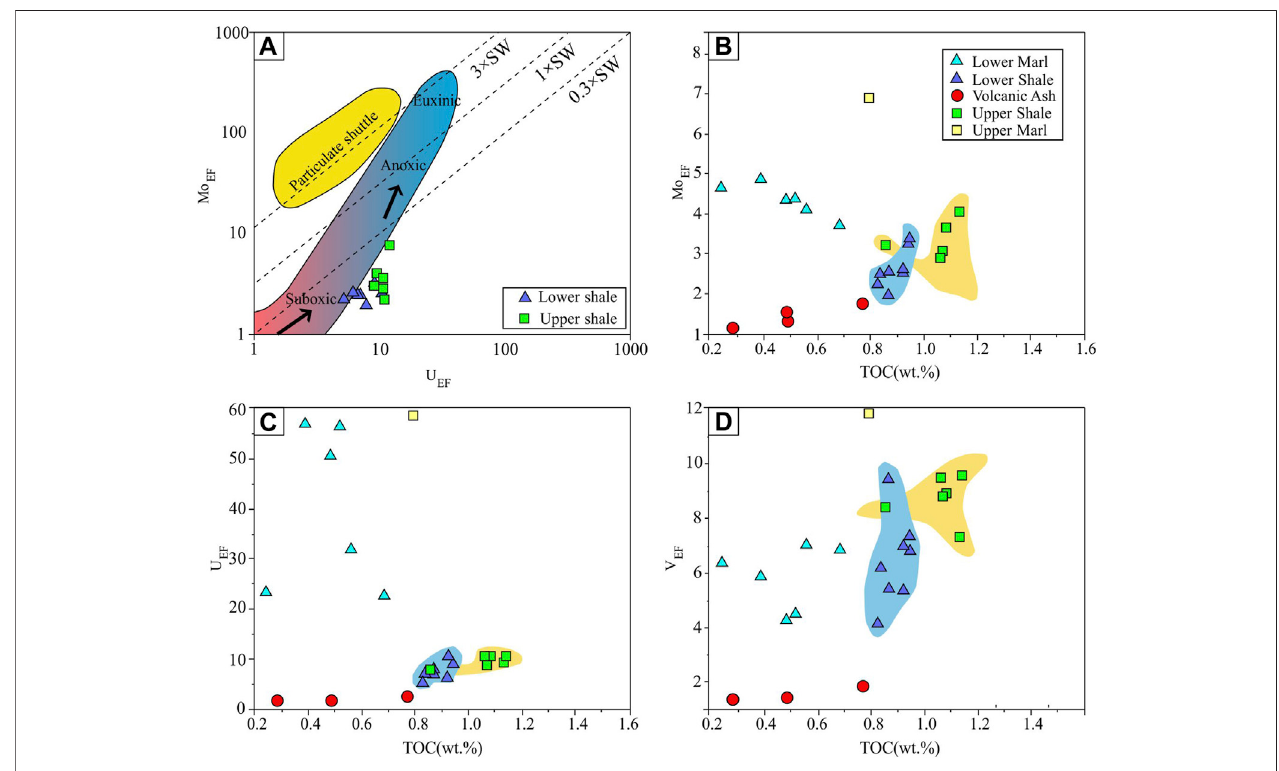
FIGURE 11 | Crossplots of (A) MoEF vs UEF, (B) TOC vs MoEF, (C) TOC vs UEF, and (D) TOC vs VEF. Three dotted lines in (A) represent that the Mo EF /U EF has a value of 0.3, 1, and 3 times that of sea water. The zone with graduated color indicates U-Mo covariance in a normal open ocean environment, and the green zone indicates U-Mo covariance with the effect of metal particle carriers [modi fi ed from Algeo and Tribovillard (2009)].